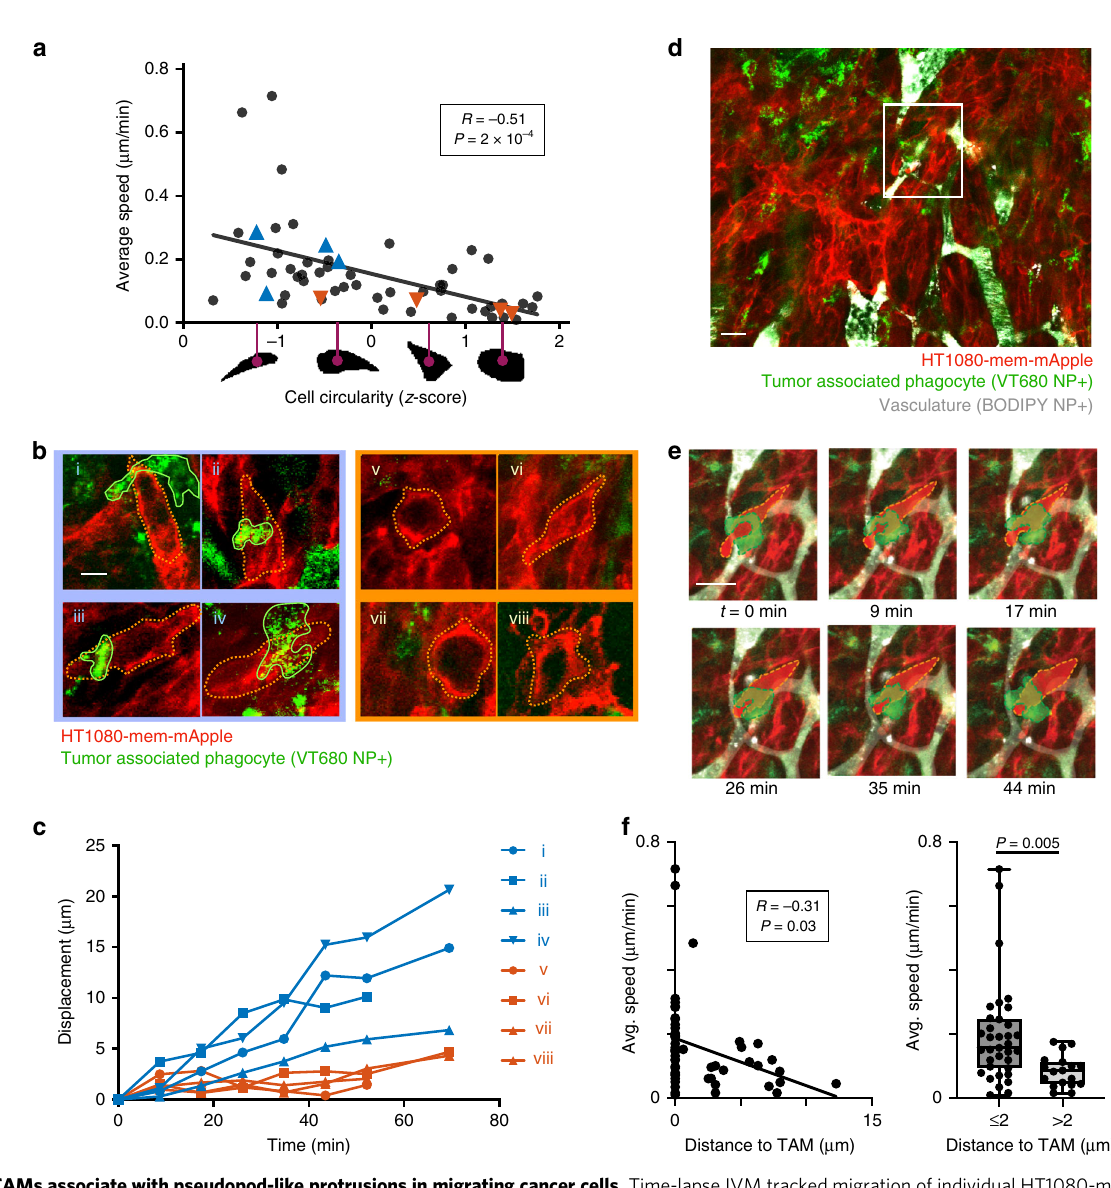
Fig. 7 TAMs associate with pseudopod-like protrusions in migrating cancer cells. Time-lapse IVM tracked migration of individual HT1080-mem-mApple cells in tumors within the dorsal window chamber model. a Migration speed was correlated with cell circularity (data points are n = 50 individual cells across n = 4 tumors; *two-tailed f test on cell level data). Blue and red correspond to cancer cells associated with TAMs or not, respectively, in ( b – c ). Representative tumor cells associated with TAMs (i – iv) or not (v – viii) are shown ( b ; scale bar = 10 μ m) with corresponding migration ( c ). Example TAM- associated, migrating HT1080 cell is highlighted from a 20× fi eld of view (d; scale bar = 20 μ m) and corresponding time-lapse (e; scale bar = 20 μ m). Cells have been shaded for visualization. f Migration speeds of individual HT1080 cells were compared with their nearest distance to TAMs, shown fi t to a regression (left; Pearson ’ s coef fi cient and two-tailed t test) and binned by distance (right; *two-tailed t test on cell level data; box plot as min, 25%tile, median, 75%tile, and max; e , f n = 55 cells across n = 4 tumors). Source data are provided as a source data fi